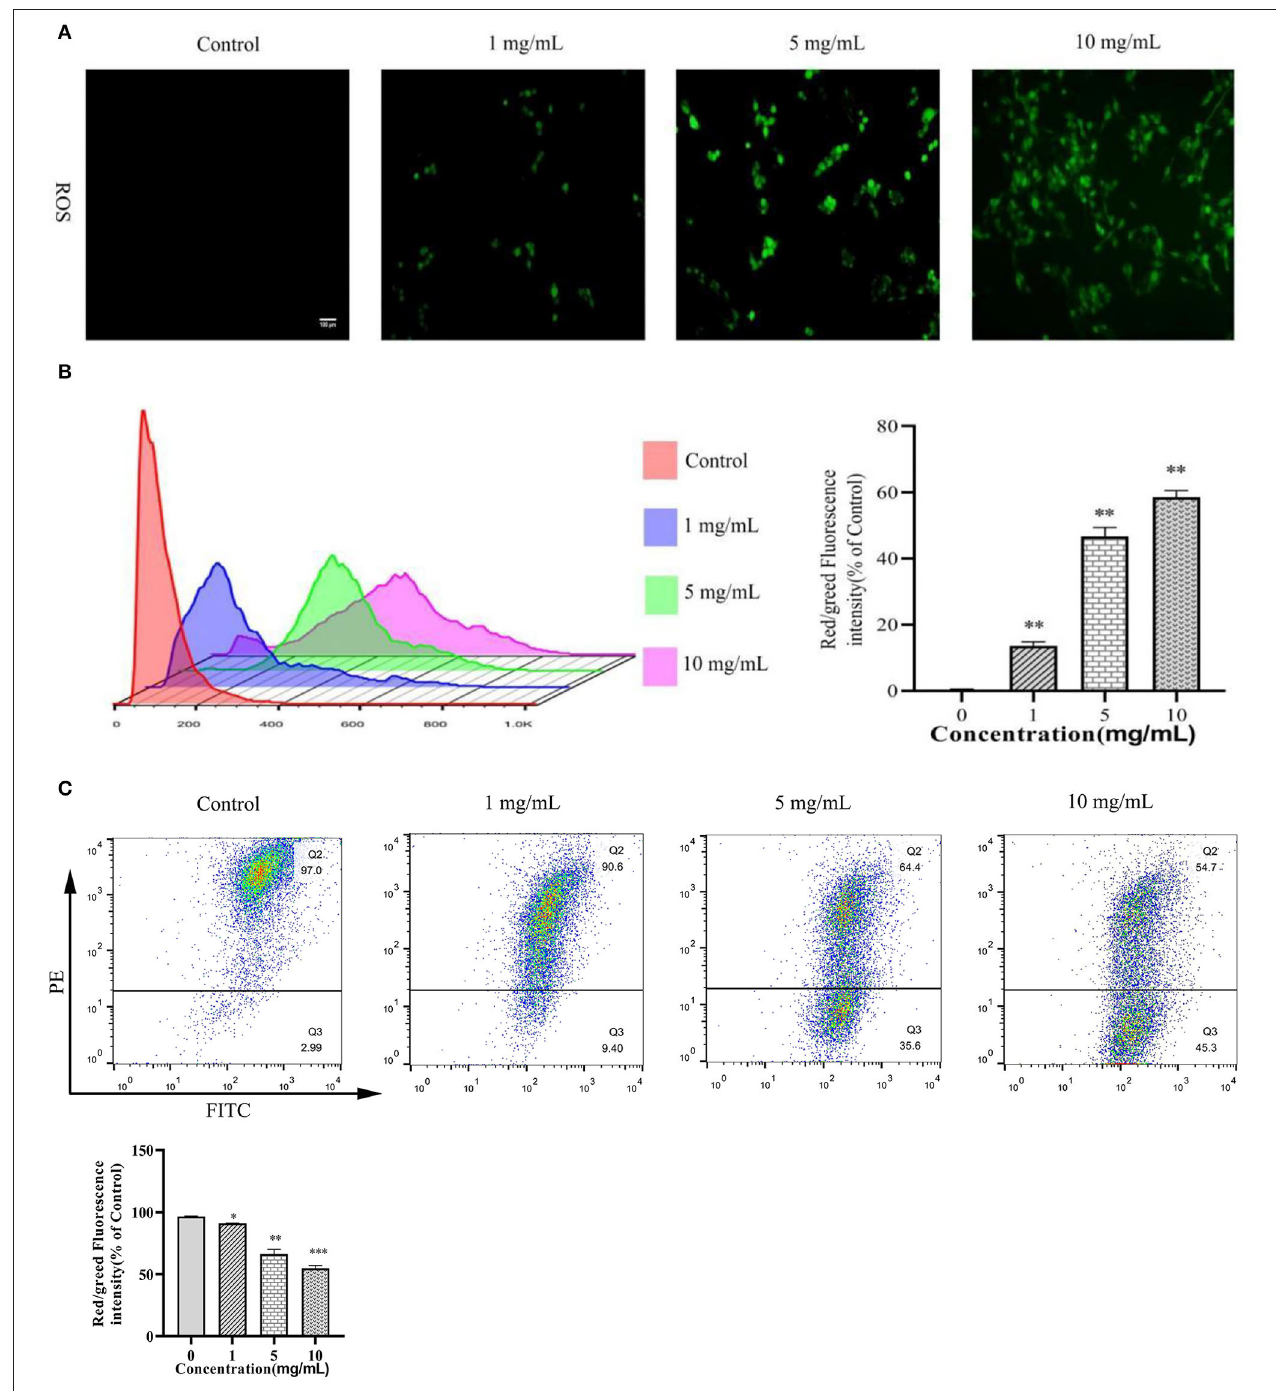
FIGURE 2 | 11S glycinin induced ROS generation and reduced MMP in IPEC-J2 cells. (A) IPEC-J2 cells were stimulated with 0, 1, 5, and 10 mg · ml − 1 11S glycinin for 24h, and ROS were detected using DCFH–DA staining. (B) The red/green fluorescence intensity was measured using flow cytometry. (C) The mitochondrial membrane potential in IPEC-J2 cells were measured using the flow cytometry. Data are shown as mean ± SD. * P < 0.05, ** P < 0.01, *** P < 0.001, compared with the control.